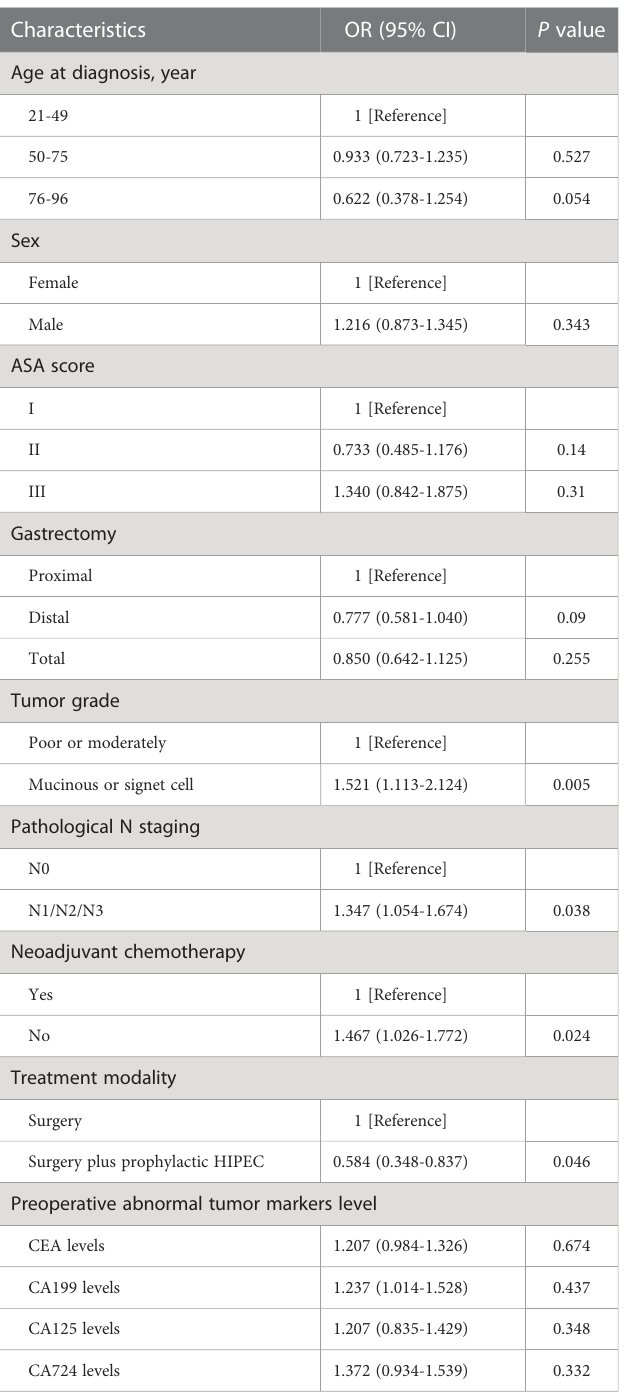
TABLE 4 Multivariable analysis of the prognostic factors in fl uencing DFS.